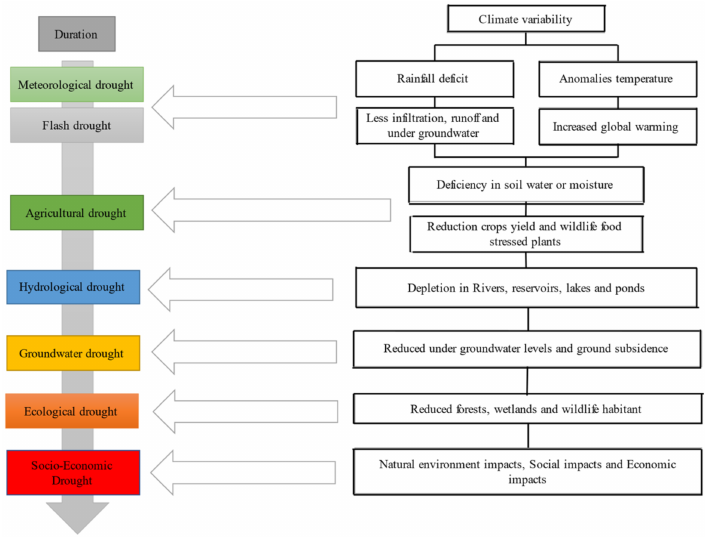
Figure 1. Classification of different types of